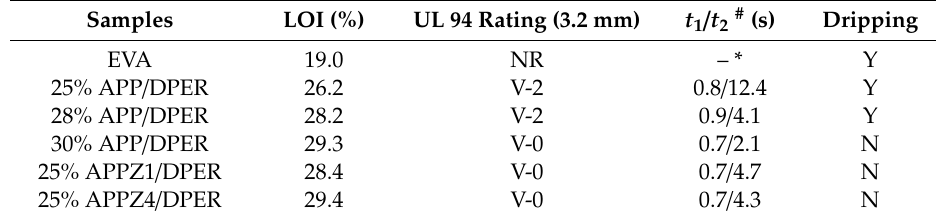
Table 3. Limiting oxygen index (LOI) and UL 94 results of EVA composites.